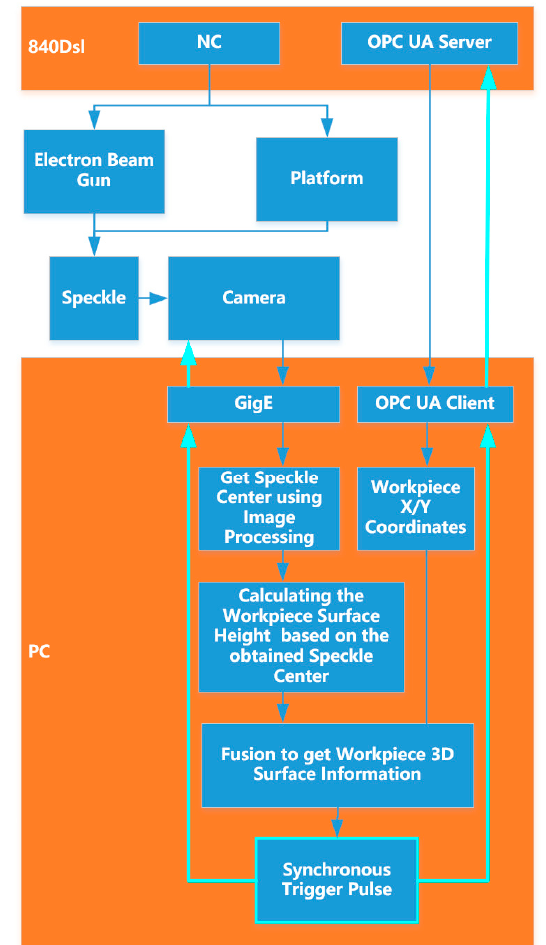
Figure 4. Flow chart of the measurement system.